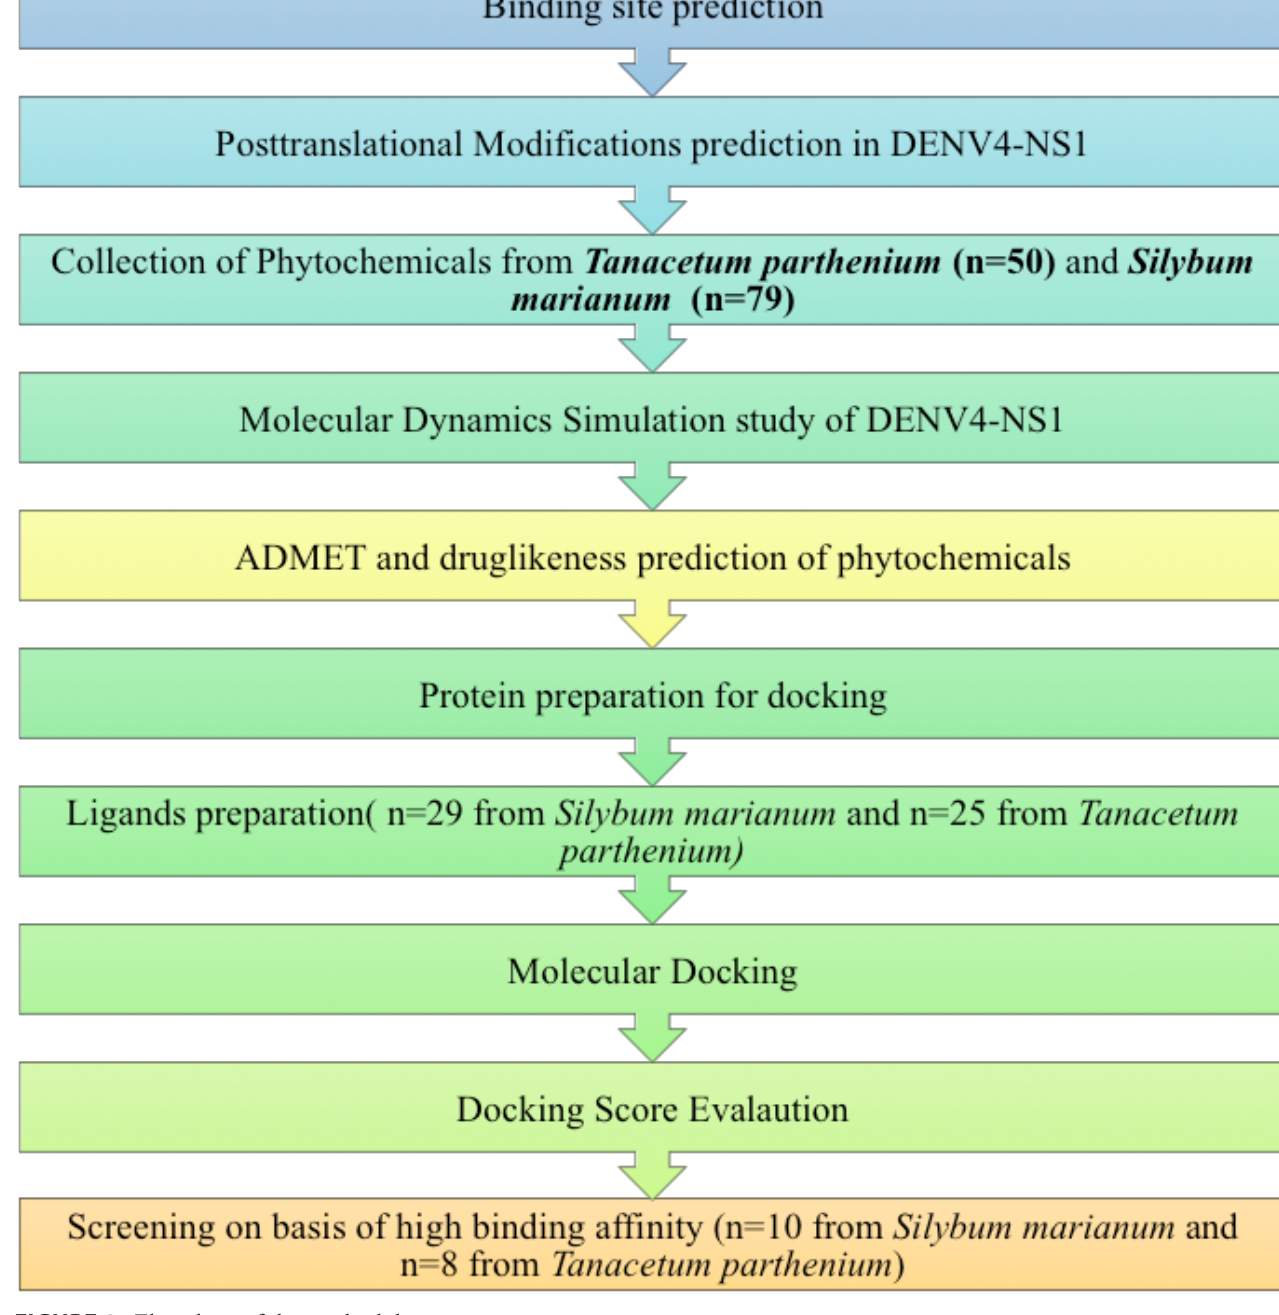
FIGURE 1 - Flowchart of the